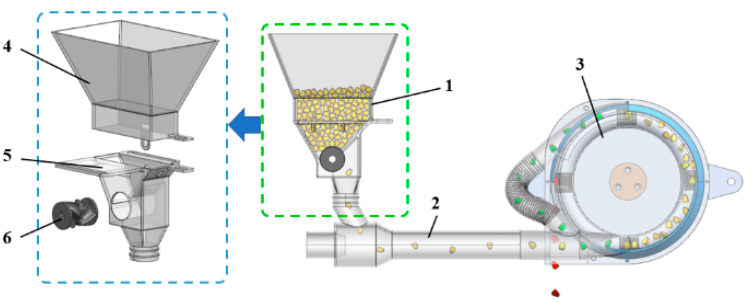
Figure 1. Air-assisted high-speed precision seed metering device. 1. Seed feeding device; 2. venturi tube; 3. seed metering device; 4. seed inlet; 5. seed filling box; 6. seed feeding wheel.